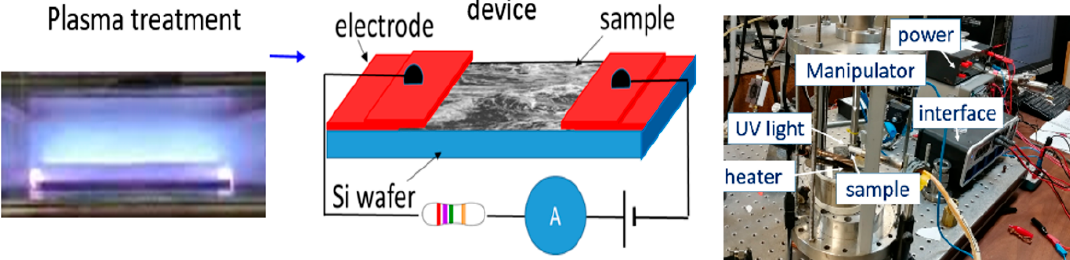
Figure 3. Process flow for nanocomposite ‐ based deep UV photo ‐ detector (DUV ‐ PD) fabrication.